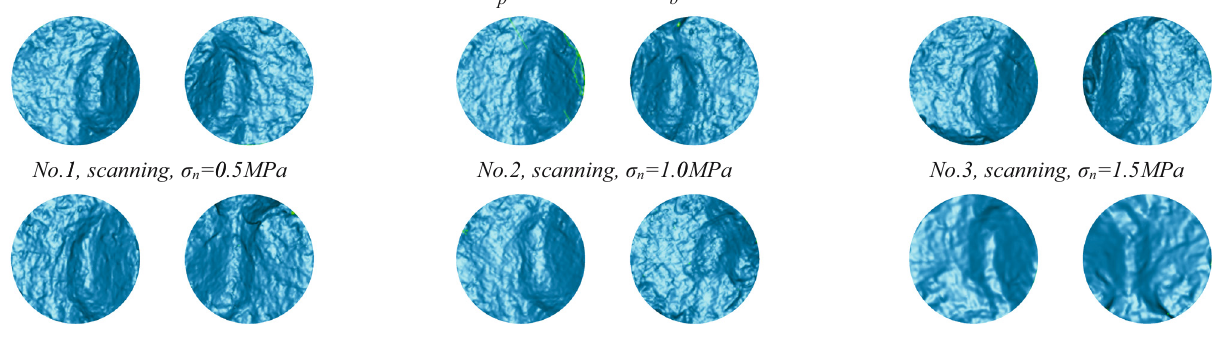
Figure 15: Laser scanning image of the structural plane after the shear test.